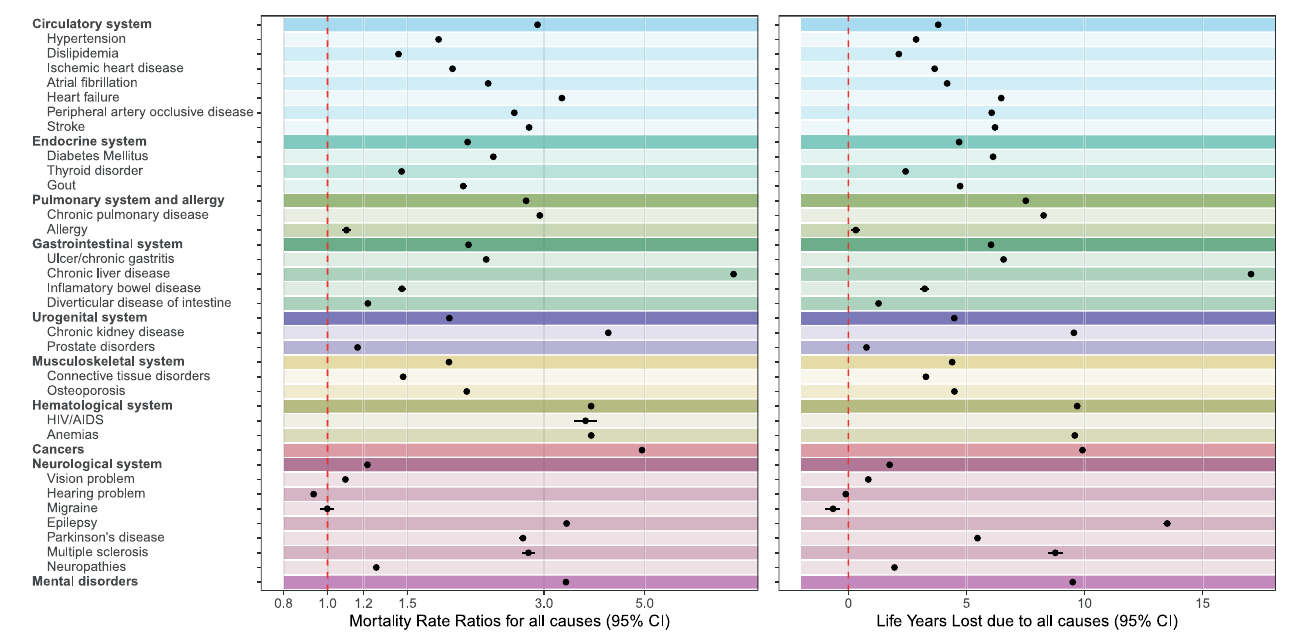
Fig 2. MRRs (left panel) and LYLs (right panel) for all causes of death for 39 selected conditions covering 10 broad categories. The red line indicates equal mortality in the 2 groups (MRR of 1; LYLs of 0). Estimates are not shown if they are based on less than 100 individuals diagnosed or less than 20 deaths; for LYLs, estimates are not shown if there were not enough individuals at older ages of follow-up. Estimates are available in S4 Table. CI, confidence interval; LYLs, life years lost; MRR, mortality rate ratio.